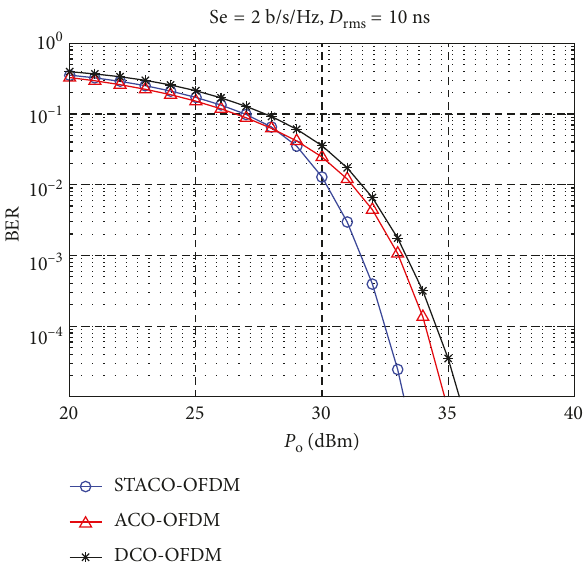
Figure 13: BER versus optical power performance of STACO- OFDM, ACO-OFDM, and DCO-OFDM with spectral efficiency of 2bits/s/Hz over multipath channel with D rms